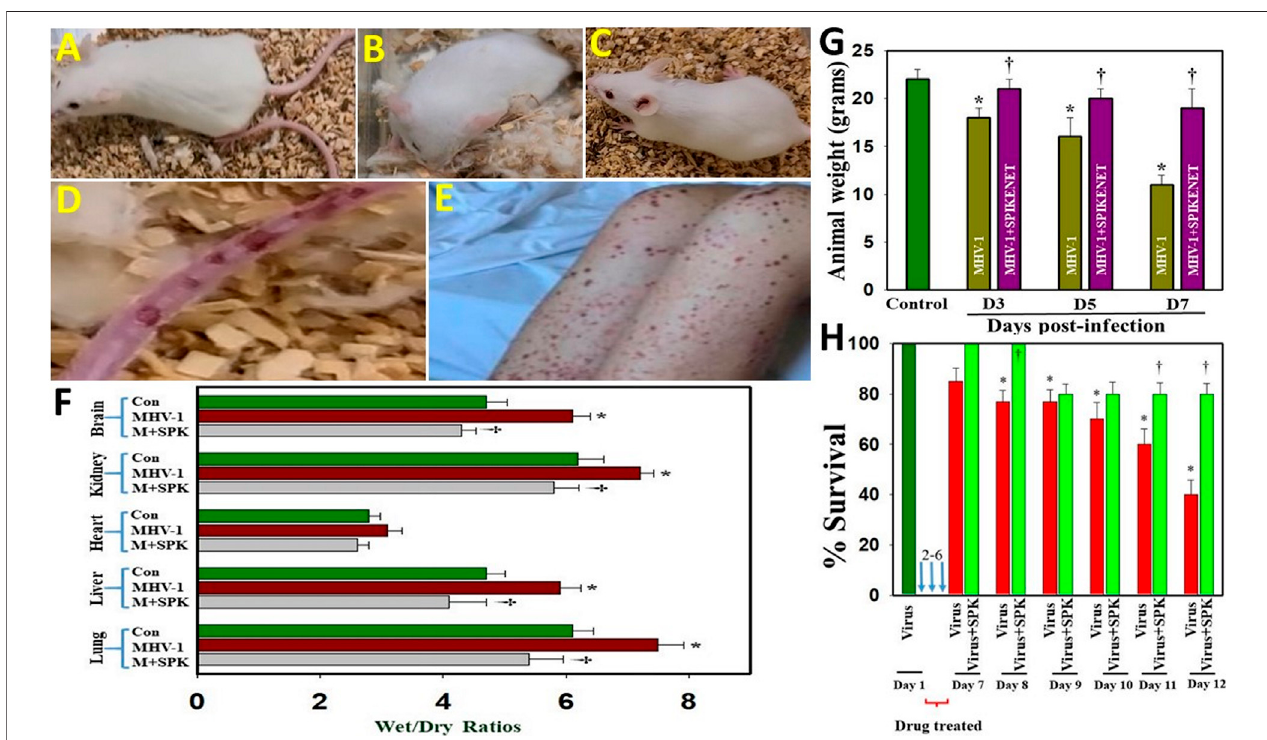
FIGURE 4 | Severe sickness in MHV-1 inoculated mice. (A) Normal mouse. (B) MHV-1 infected mice showing sickness. (C) MHV-1 inoculated mice treated with 5 mg/kg SPIKENET (SPK) ameliorated the clinical symptoms and disease progression. (D) MHV-1 infected mice showing venous thrombosis similar to symptoms in patients with COVID-19 (E) . Elevated edema was observed in MHV-1 infected brain, lung, liver, kidney, and heart, as compared to control (F) . Treatment of MHV-1- infectedmice withSPK(5 mg/kg;3injections from2to6 days)showededemalevelsimilar tocontrolon day7 (F) .SPK alsoreversedMHV-1-induced reduction in animalweight (G) ,aswellasimprovedsurvival (H) .ANOVA, n =5forcontrol; n =16forvirusaloneand n =7forMHV1+SPKgroup(similarlyfor Figures5 , 6 (seebelow). * p < 0.05 versus control; † p < 0.05 verses MHV-1 infected mice. Con, control. Error bars represent mean ±